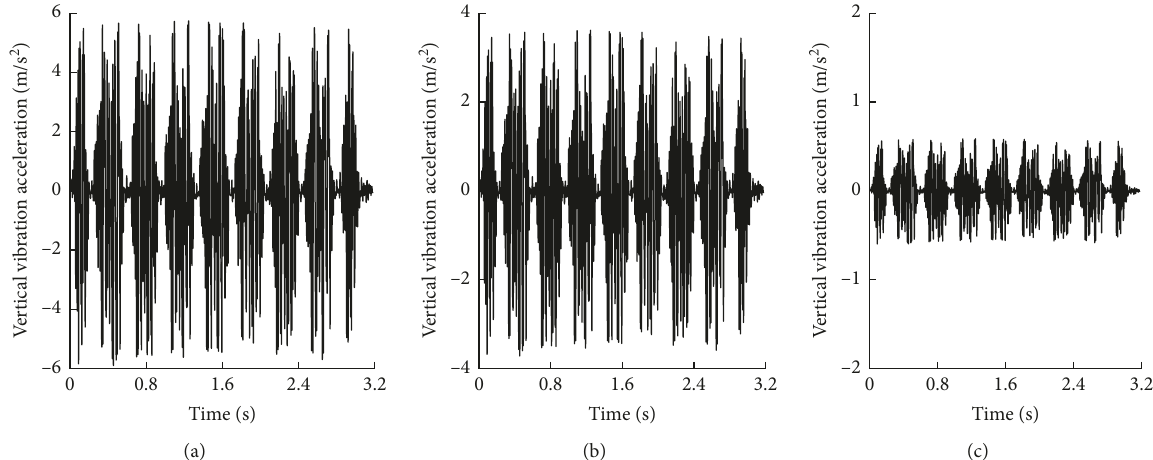
Figure 9: The vertical vibration acceleration history curves of the ballastless track-subgrade with mud pumping ( v slab. (b) The concrete base. (c) The subgrade surface.